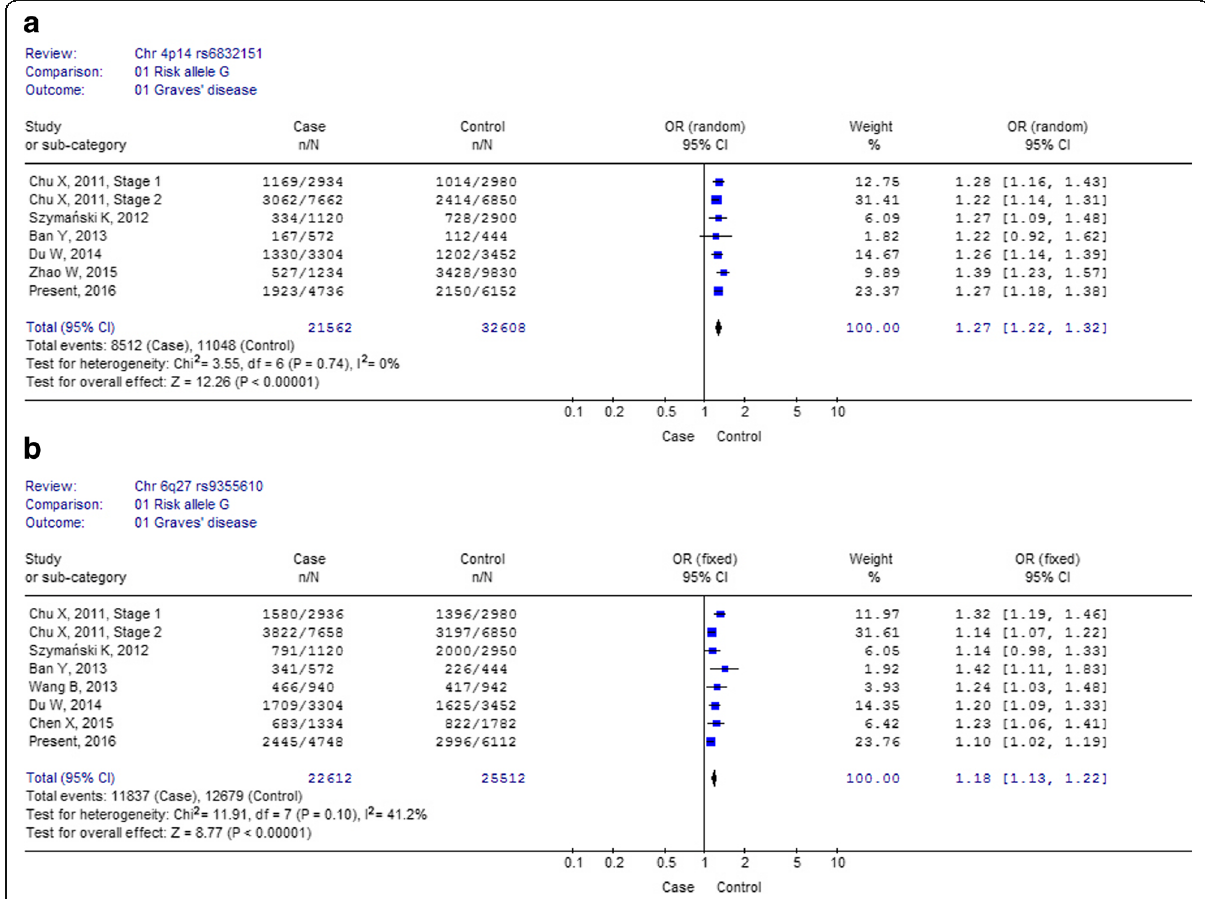
Fig. 1 Forest plots of Meta-analysis for the association of rs6832151 and rs9355610 with GD susceptibility measured by allele frequency data. OR ( black squares ) and 95% CI ( bar ) are shown for each study. The pooled ORs and their 95% CIs are represented by the shaded diamonds. The symbol n indicates the total number of the risk alleles, and N indicates the total number of the risk alleles plus the protective alleles. a Meta-analysis of the association studies of rs6832151; b Meta-analysis of the association studies of